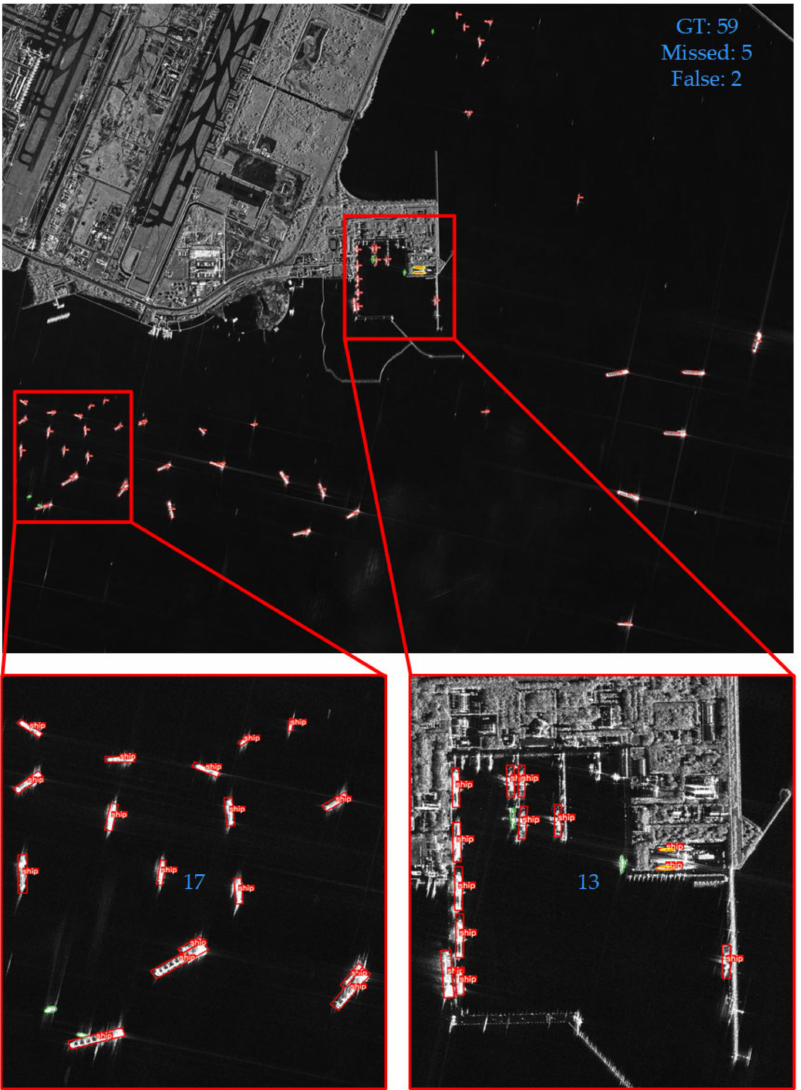
Figure 16. Detection results in large-scene SAR image. Note that the red boxes represent true positive targets, the yellow ellipses represent false positive targets and the green ellipses represent missed targets; and the blue number represents the number of detected